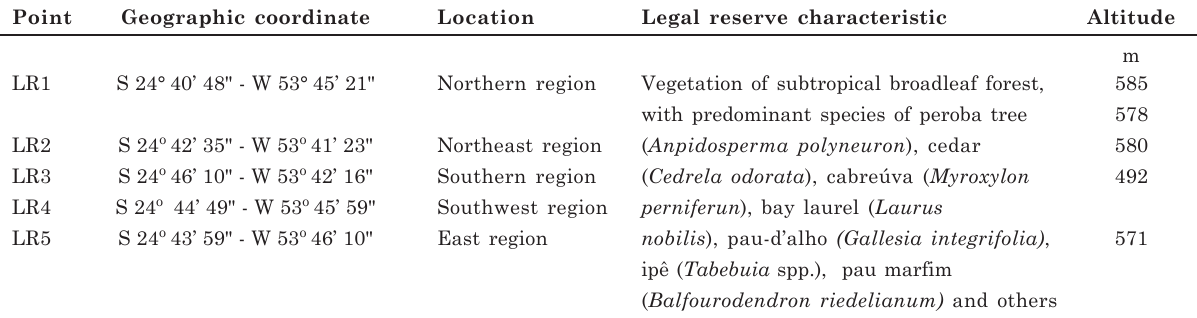
Table 1. Sampling description (geochemical background) in study